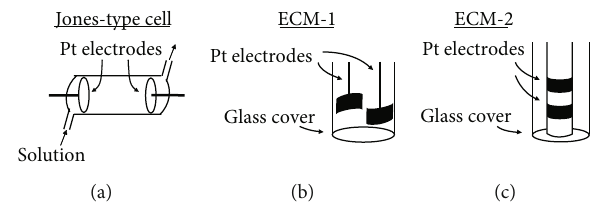
Figure 1: Graphical image of (a) NMIJ secondary Jones-type cell and (b and c) commercially available electrolytic conductivity meters (ECMs). The electrodes of commercial cells are platinum